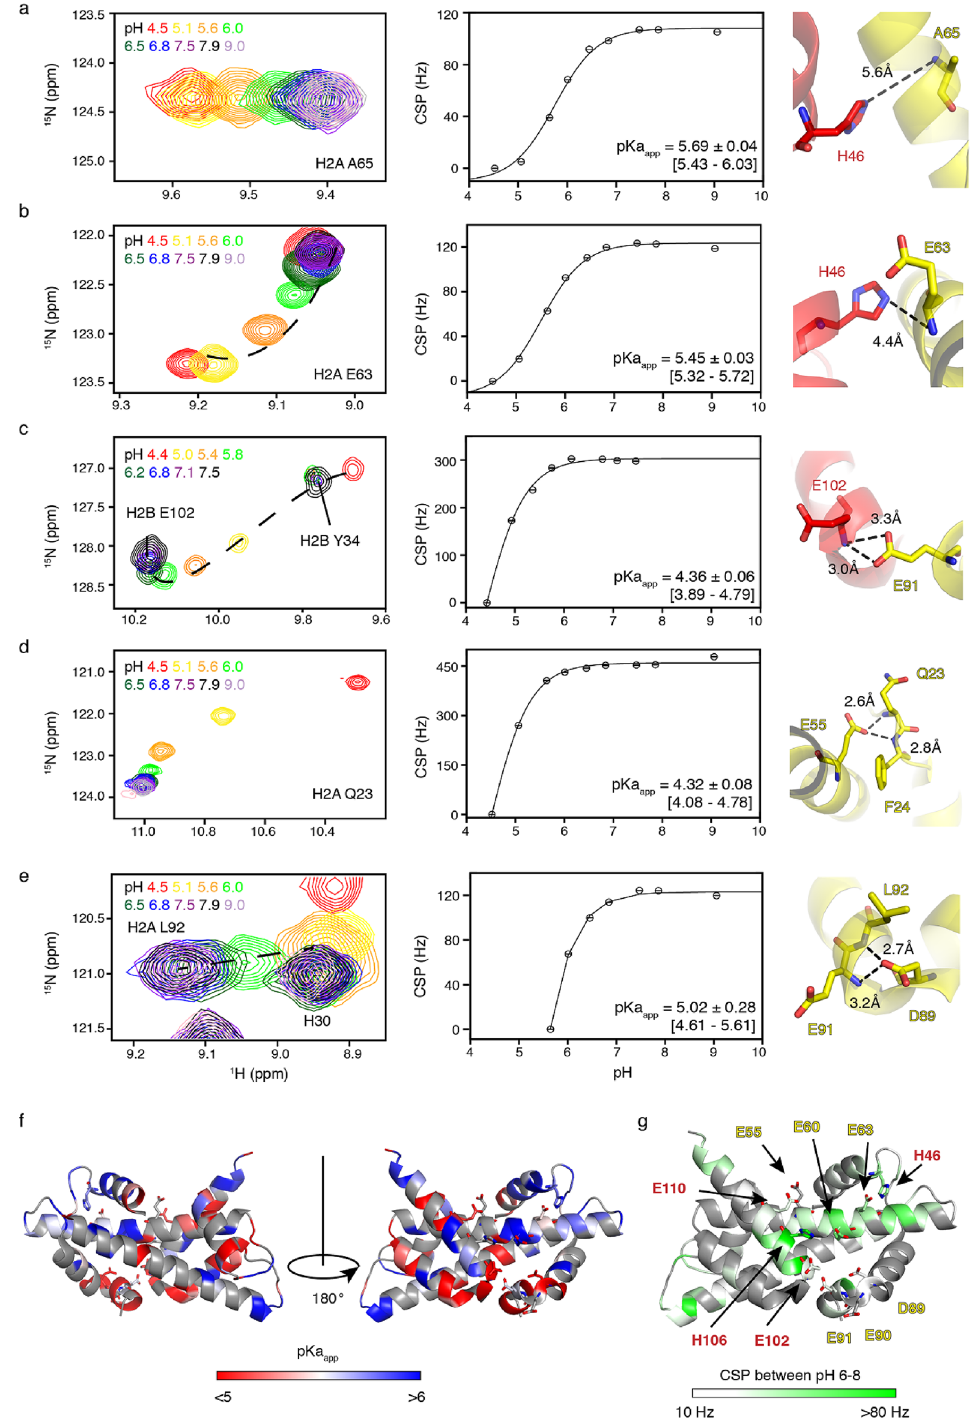
Figure 4. Apparent pKa of H2A-H2B dimer core region measured by NH chemical shift perturbations. ( a–e ) Overlay of HSQC spectra at indicated pH values shown on the left, CSP-derived titration curves with fitted pKa app in the middle, and the local structure on the right for selected residues. Best-fit values of pKa and standard deviation are shown on the titration curve, together with 95% confidence interval in brackets. As the resonance of L92 (panel e) could not be tracked below pH 5.6, the fit is based on the pH 5.6–9.0 data. ( f ) Color coding of fitted pKa app values on the H2A-H2B structure. ( g ) Color coding of the CSP between pH 6 to 8 on the H2A-H2B structure. Color coding in ( f , g ) indicated in the figure. Residues with no data are colored grey. Acidic patch residues and H2B H46 and H106 are shown as sticks. Structure is taken from the nucleosome structure (PDB-id: